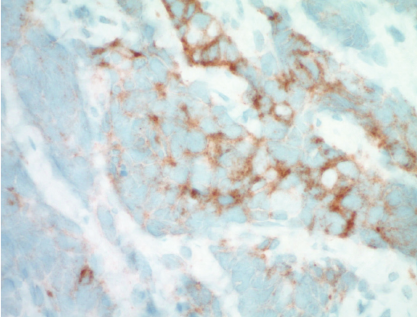
Figure 4: Ancillary testing confirmed immunoreactivity with synaptophysin (synaptophysin immunohistochemistry, 600x).